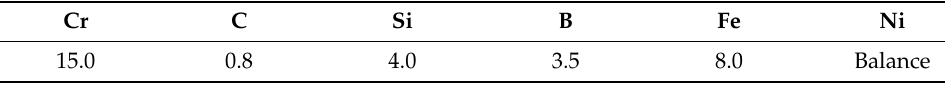
Figure 2. ( a ) Original morphology of copper pipe, ( b ) morphology of Ni60A coating on copper pipe by plasma cladding and ( c ) sampling method. Table 1. Chemical composition (wt.%) of the Ni60A